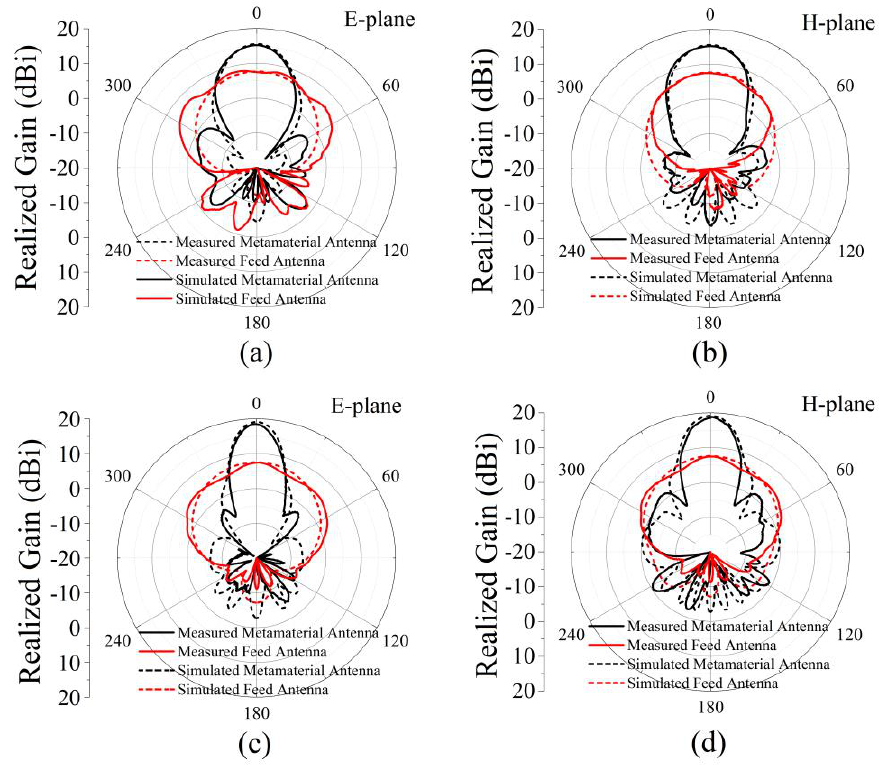
Figure 14. Measured (solid lines) and simulated (dashed lines) radiation patterns on the ( a , c ) E-plane and ( b , d ) H-plane. Measured results ( a , b ) at 3.75 GHz and ( c , d ) 5.60 GHz. Simulated results ( a , b ) at 3.73 GHz and ( c , d ) 5.66 GHz. The black lines are the results for the metamaterial antenna, and the red lines are the results for the feed patch antenna.